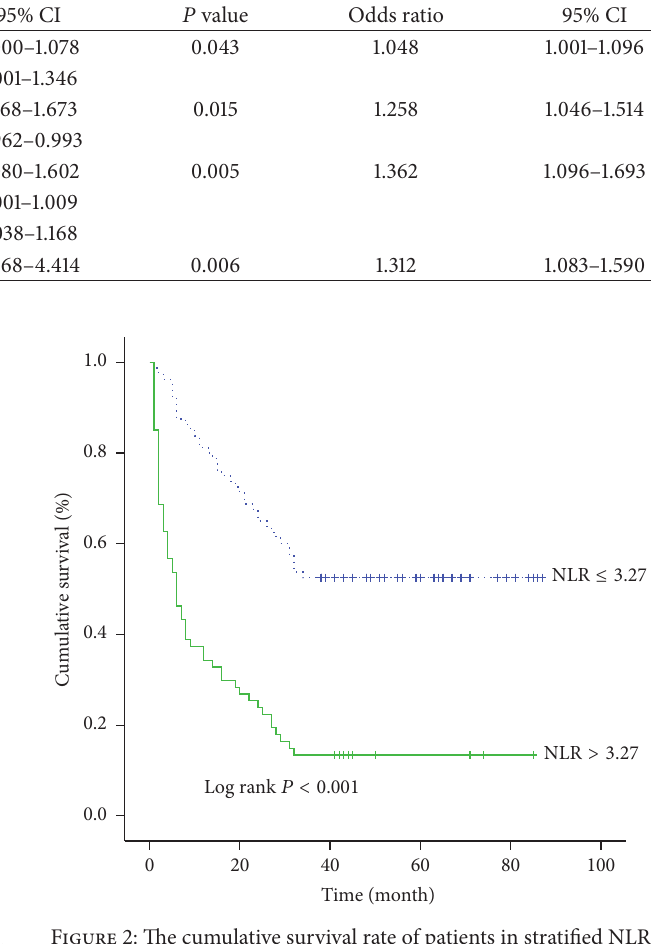
Figure1:ThecumulativesurvivalrateofpatientsinstratifiedHbA1c groups.